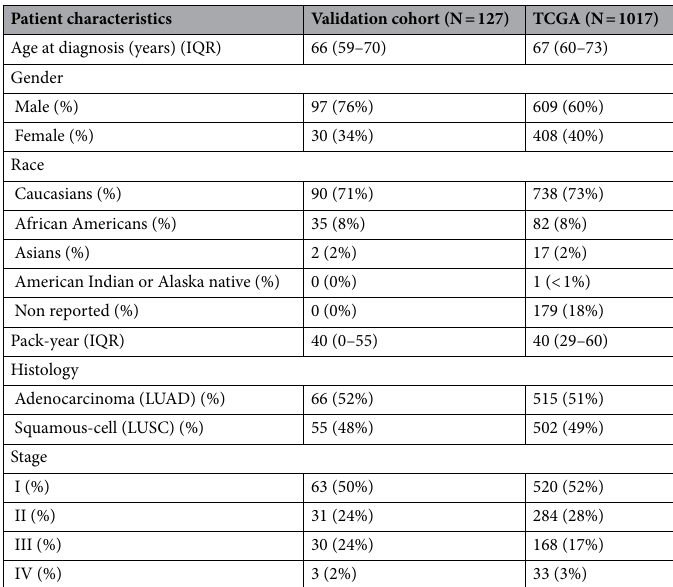
Table 1. Baseline characteristics TCGA vs validation cohort. IQR interquartile range.